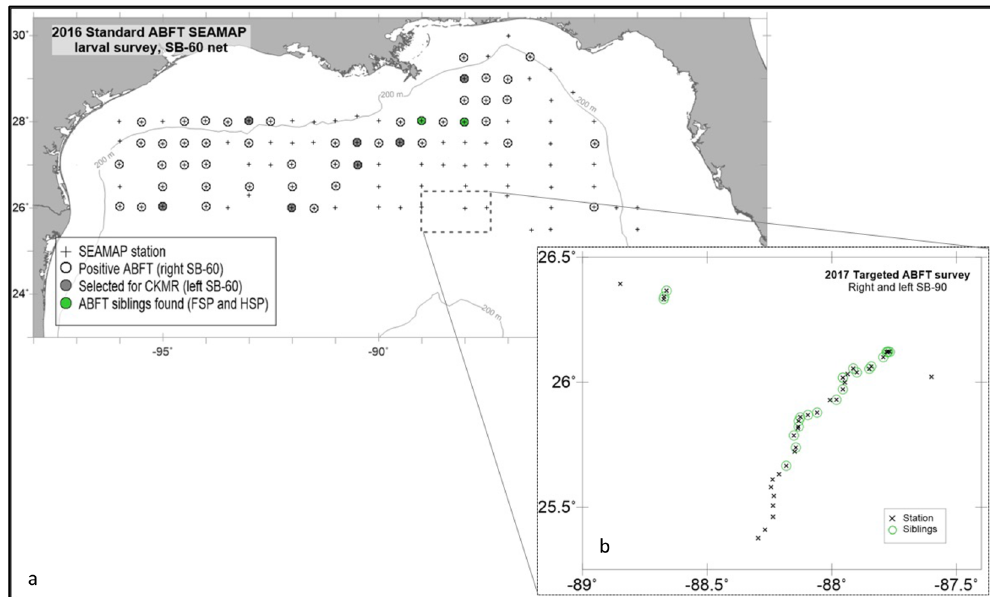
Figure 1. Larval Atlantic bluefin tuna (BFT) collected during two oceanographic surveys in the northern GoM, ( a ) 2016 standard ichthyoplankton survey ( b ) Insert: 2017 targeted larval survey. Stations are indicated with a + or x, in 2016, positive BFT stations that were selected for close kin mark recapture (CKMR) are displayed with closed symbols (gray filled circle). Surveys found to have siblings (full sibling pairs and half sibling pairs) are denoted by green symbols. The image was created in Surfer 9 (Golden Software LLC, Golden CO), https:// www. golde nsoft ware. com/ produ cts/